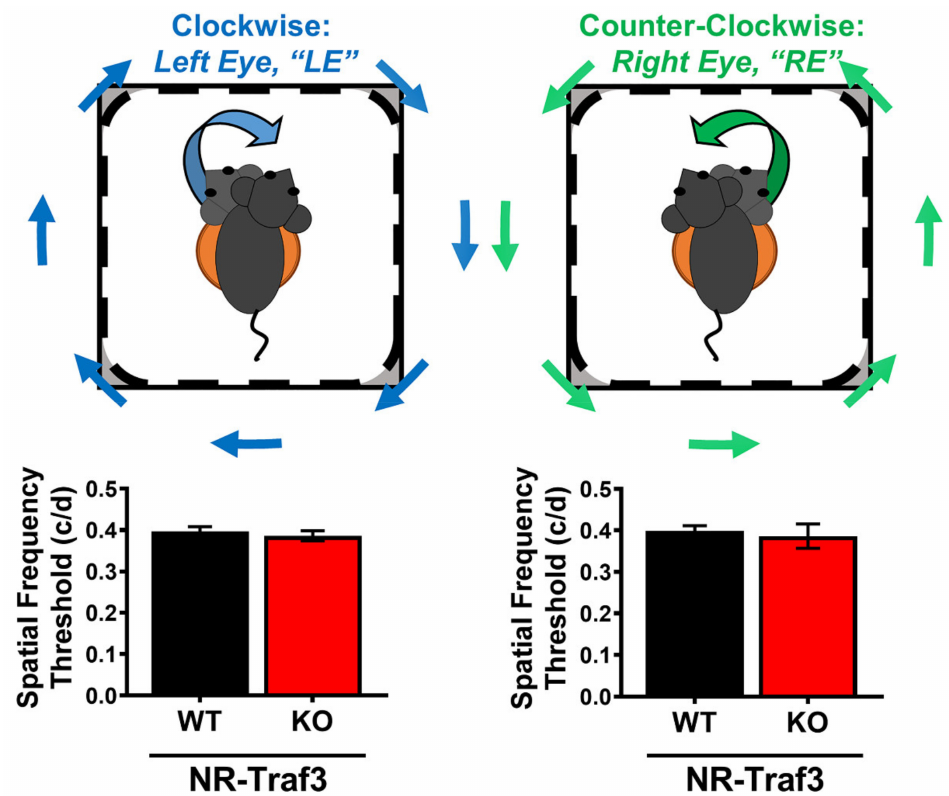
Figure 4. NR- Traf3 depletion does not affect basal visual acuity. Schematic (top) shows virtual cylinder grating rotation direction for left eye (LE, clockwise) and right eye (RE, counter-clockwise) spatial frequency determinations. Visual acuity data for left and right eyes show no difference in visual thresholds between NR- Traf3 WT and KO animals. ( n = 5–12; Student’s t -test, not significant).